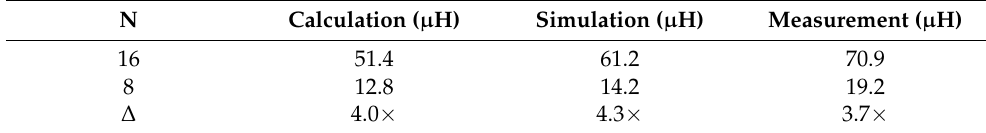
Table 6. Transformer leakage inductance under modification of winding